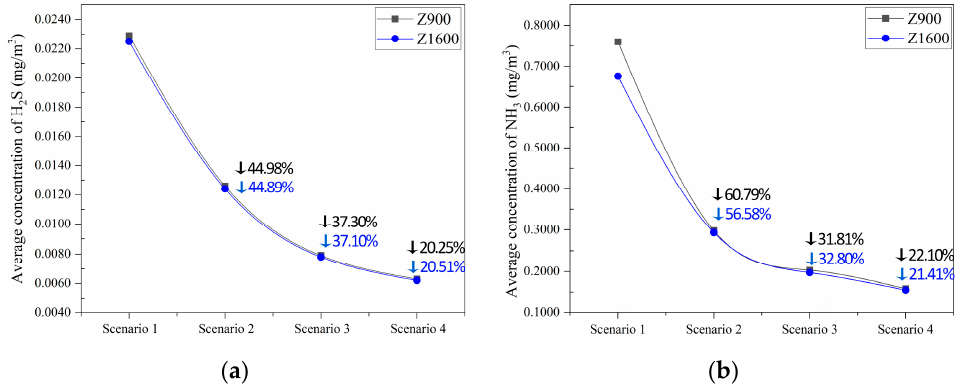
Figure 7. Variation trend in the ACIPs with the frequency of air exchanges. ( a ) Average concentration of H 2 S; ( b ) Average concentration of NH 3 . Table 7. Boundary conditions for air velocity at exhaust vent.